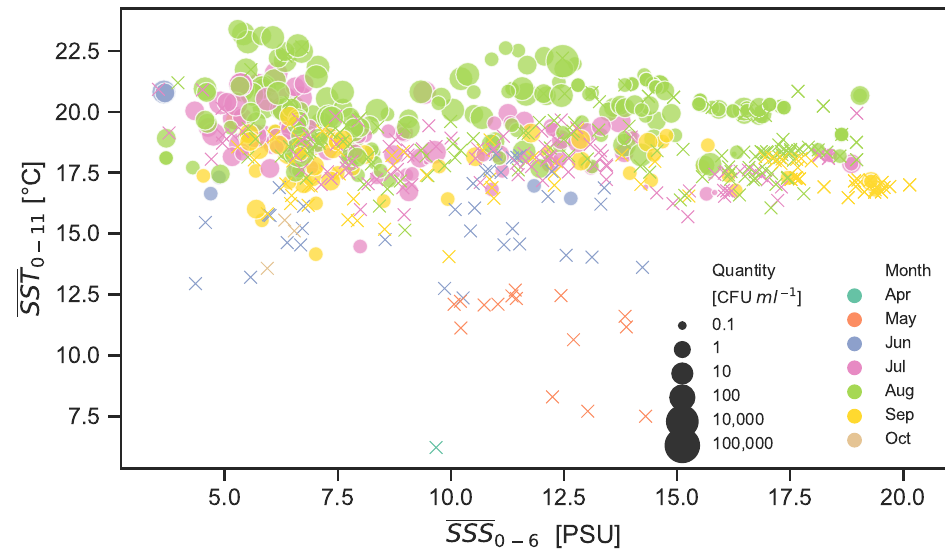
Figure 5. Bubble plot showing V. vulnificus quantities (indicated by bubble size) in relation to average SST and SSS of the days before the sampling event. Negative V. vulnificus samples are indicated with crosses. The sampling month is denoted by the colour of the crosses and